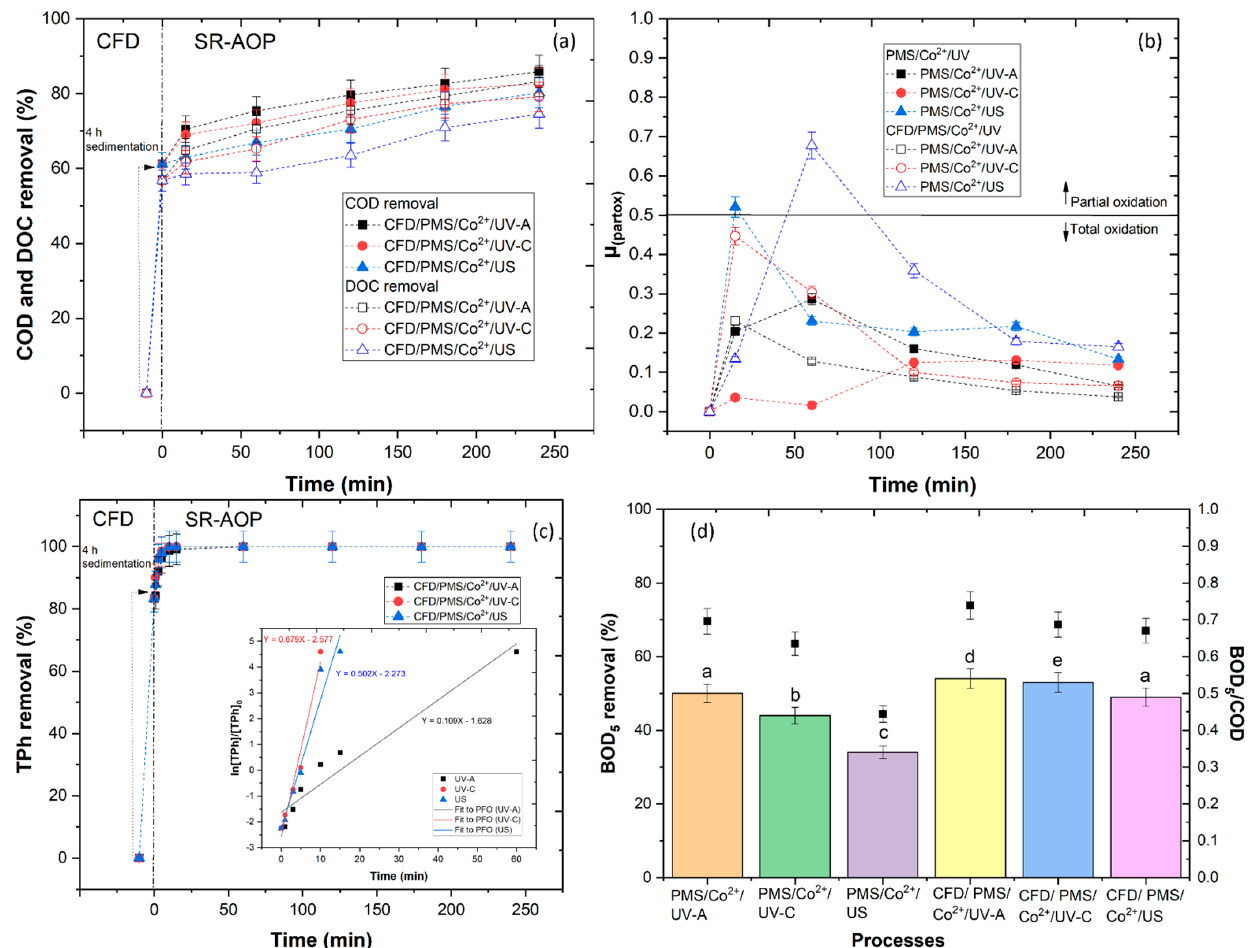
Figure 8. Effect of CFD/PMS/Co 2+ /radiation in ( a ) COD and DOC removal, ( b ) µ (partox) , ( c ) TPh removal and ( d ) BOD 5 removal and BOD 5 /COD. Means in bars with different letters represent signif- icant differences ( p < 0.05) within BOD 5 /COD by comparing treatment processes. CFD operational conditions: pH = 3.0, [ASE] = 0.5 g/L, fast mix (rpm/min) = 150/3, slow mix (rpm/min) = 20/20, sedimentation time 4 h. SR-AOP operational conditions: pH = 6.0, [PMS] = 5.88 mM, [Co 2+ ] = 5 mM, radiation UV-A 32.7 W m − 2 , UV-C 15 W, US 500 W, T = 343 K, reaction time = 240 min.